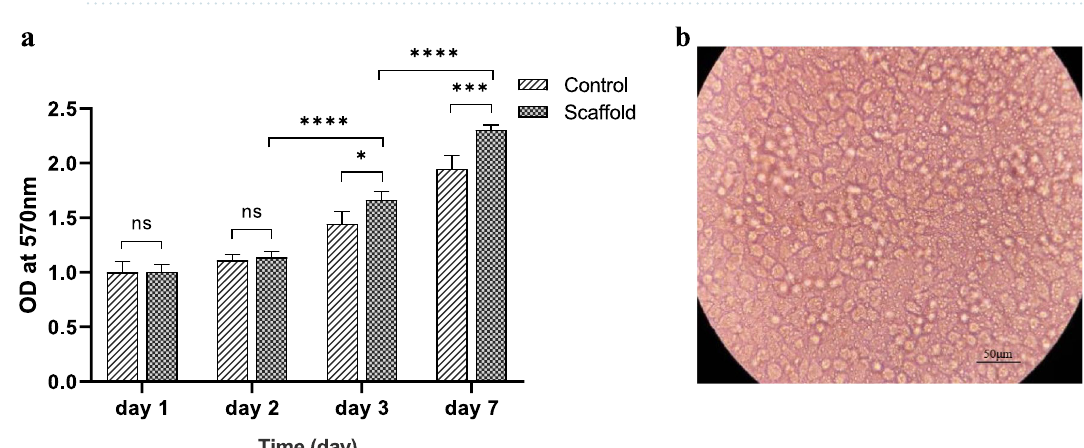
Figure 7. ( a ) Viability and proliferation of HCECs cultured on CSNP/PCL 50/25 membrane compared with control group. Data was represented as mean ± SD. ( b ) Light microscopy of the confluent HCECs cultured on the CSNPs/PCL 50/25 membrane at day